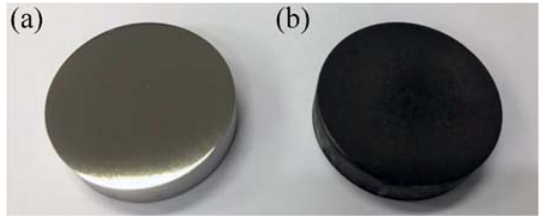
Figure 6. The photo-images of ASS samples ( a ) untreated and ( b ) low-temperature